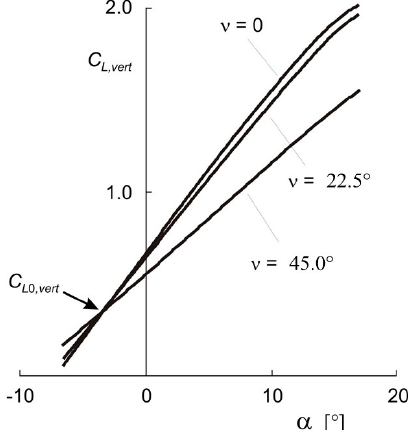
Figure 3. Lift coefficient acting in vertical direction dependent on angle of attack.